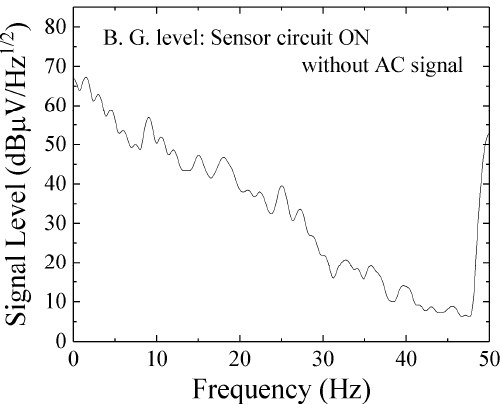
Figure 15. Noise level with connection of the sensor unit without AC magnetic field.